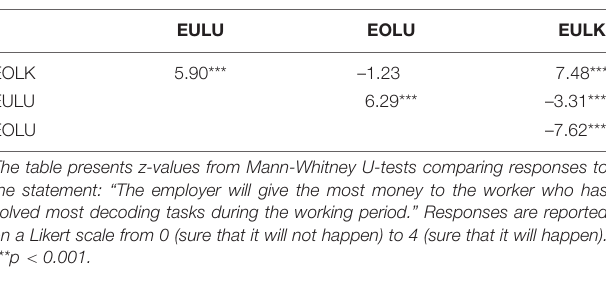
TABLE 4 | Comparison of belief about whether the employer will reward effort.